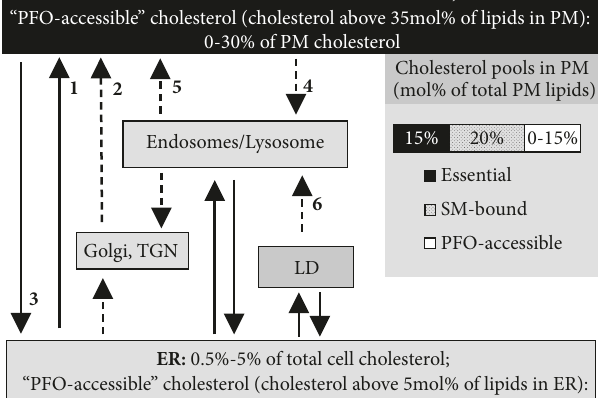
Figure 1: Cholesterol distribution and movement between major compartments.Solid arrows indicatenonvesicularcholesteroltrans- port (including transport via membrane contact sites and lipid transfer proteins); dashed arrows indicate vesicular transport and transport of cholesterol mediated by organelles. The numbers indicate the following: (1) the major nonvesicular, not cytoskeleton- dependent, energy-dependent path of cholesterol transport from ER to PM; (2) the minor vesicular transport from ER to PM via Golgi; (3) not energy-dependent, cytoskeleton-dependent choles- terol transport from PM to ER; (4) transport of LDL bound by LDL receptor in clathrin-coated vesicles; (5) energy-dependent, cytoskeleton-dependent cholesterol transport via lysosome-related organelles; (6) lysosomal degradation of LD. Three pools of choles- terols with different accessibility to water phase are known in PM. PFO-accessible cholesterol is the most available pool for the inter- actions with reagents in aqueous phase, such as PFO (Perfringolysin O), cholesterol oxidase, and cyclodextrin. This pool with variable size is considered as a putative “active” cholesterol. The size of this pool is very small at cholesterol depletion, while at the increase of its size in PM cholesterol moves to the ER. PFO-accessible pool in ER appears at much smaller mol% of cholesterol. PM (plasma membrane), ER (endoplasmic reticulum), LD (lipid droplets), TGN (trans-Golgi network), LDL (low-density lipoprotein), and SM